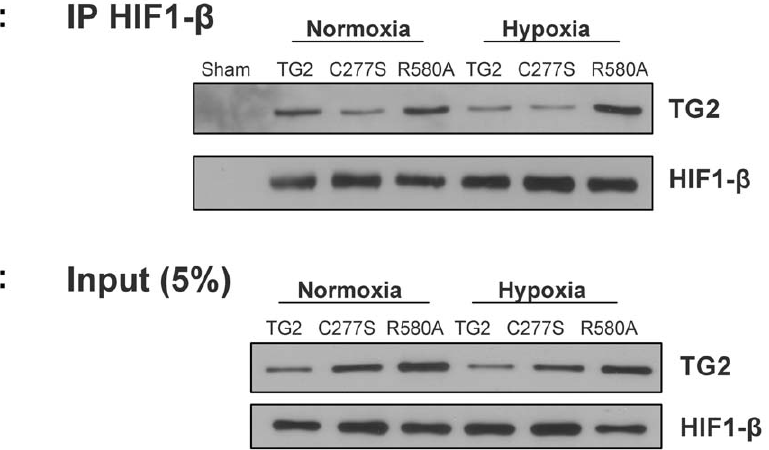
Figure 2. Interaction of TG2 with HIF-1 b . A , Representative immunoblots showing the coimmunoprecipitation of TG2 with HIF-1 b . Top panel: HIF-1 b was immunoprecipitated from the cell lysates of stable striatal cell lines and blotted for TG2. Bottom panel: The top blot was stripped and re- probed for HIF-1 b . Wild type TG2, and the mutants TG2-C277S (C277S), TG2-R580A (R580A) immunoprecipitated with HIF-1 b . B , 5% of the total amount of cell lysate used for immunoprecipitation was blotted for TG2 and HIF-1 b